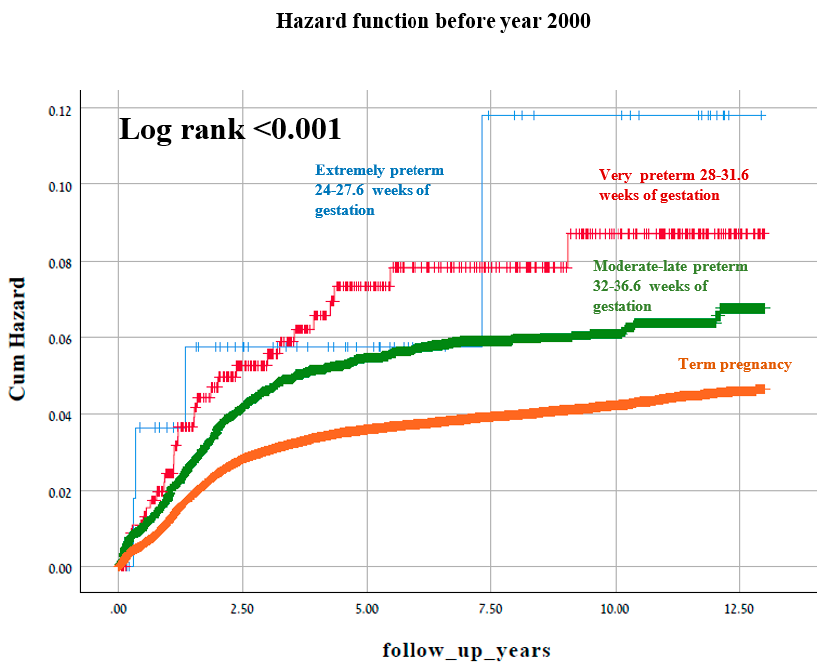
Figure 2. A Kaplan–Meier survival curve demonstrating the cumulative incidence of long-term neu-